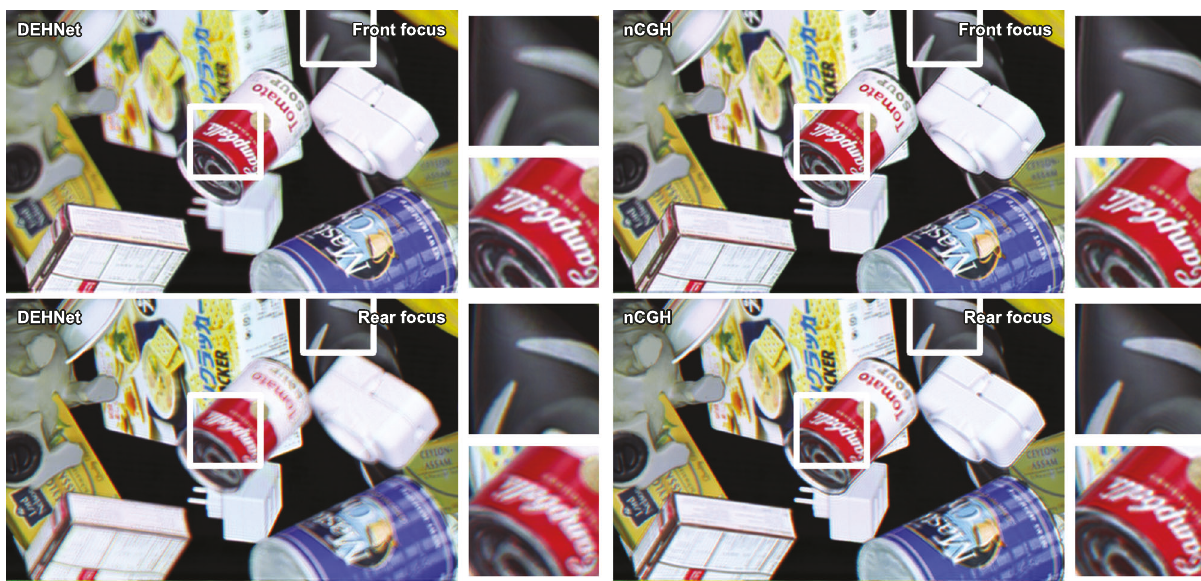
Fig. 4 | Experimental results of the DEHNet and the nCGH. The top images correspond to the front focus images and the bottom images correspond to the rear focus images. The small images represent enlargements of the corresponding reconstructions, as indicated by the white squares.